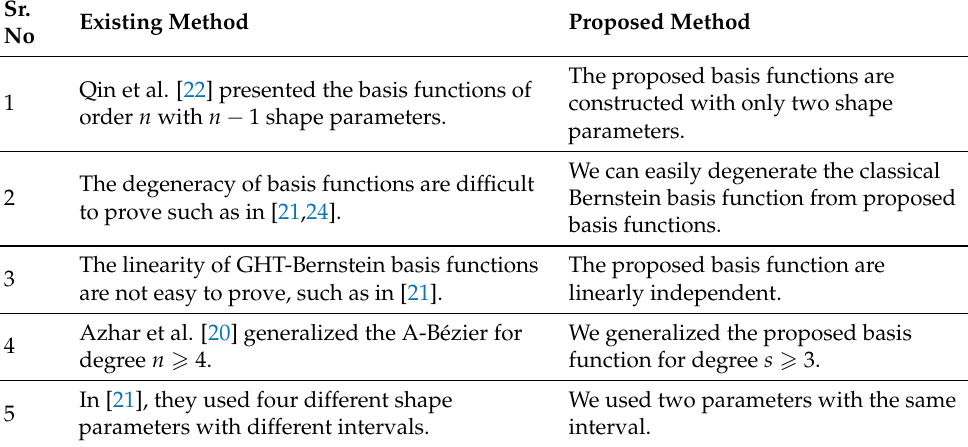
Table 1. Comparison of research